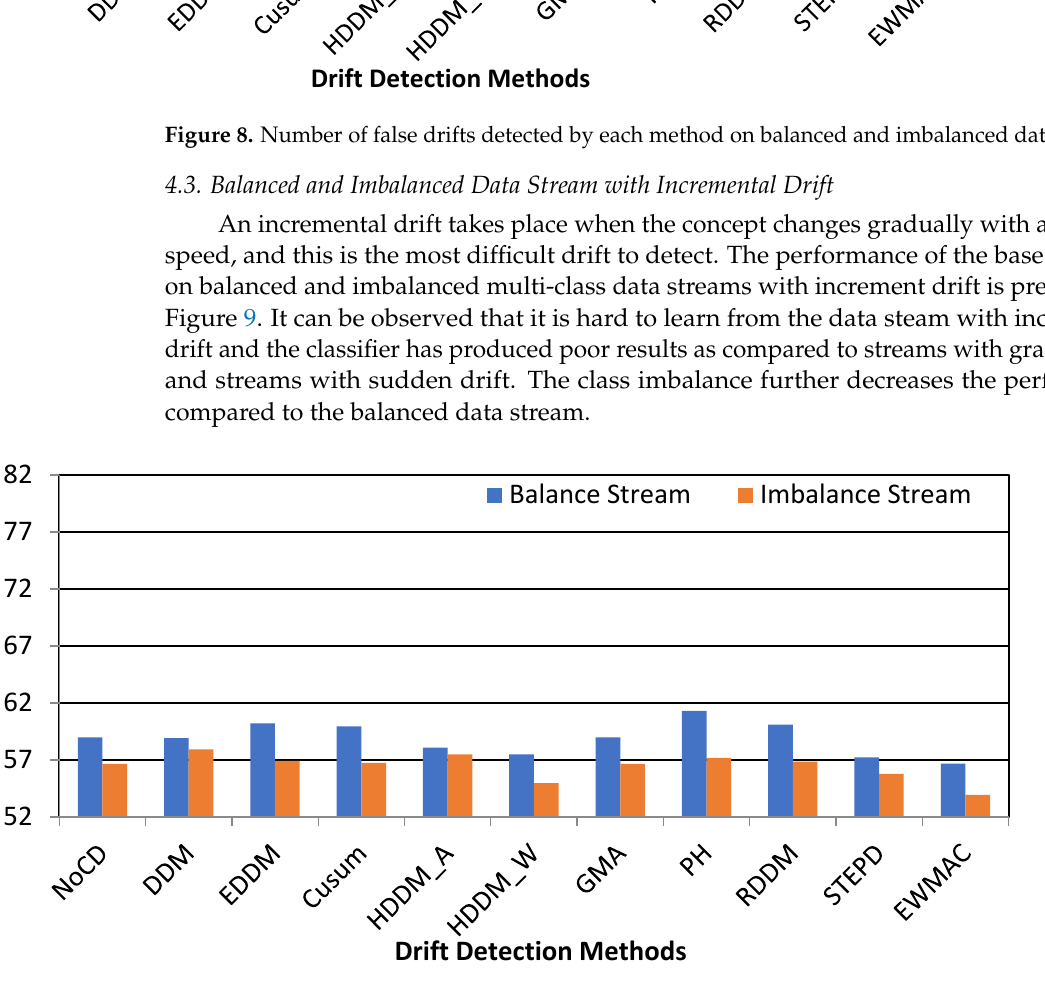
Figure 9. F1 score on balanced and imbalanced data streams with incremental drift.